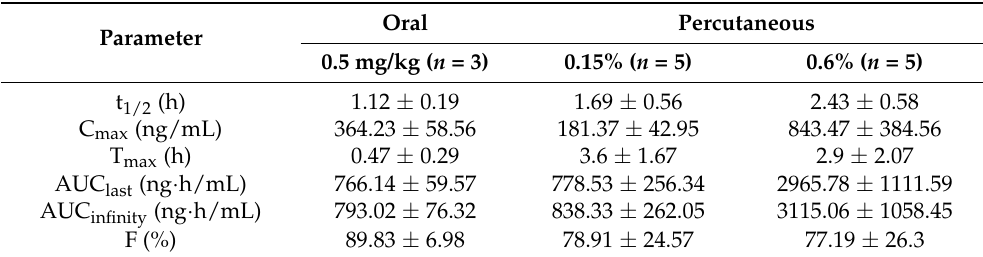
Table 4. Average non-compartmental toxicokinetic parameters of hexamethylenetetramine obtained after oral and percutaneous administration in